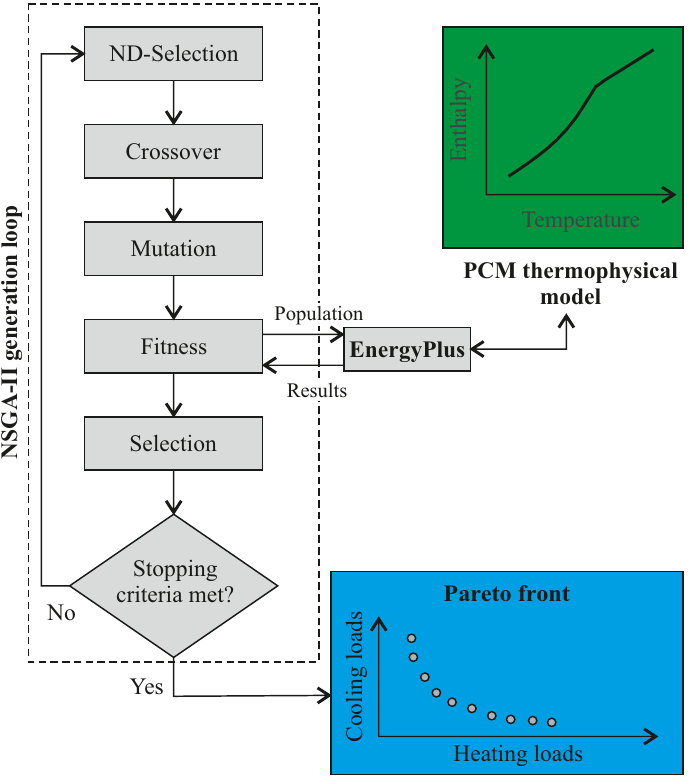
Figure 4. Schematic workflow of the proposed method.